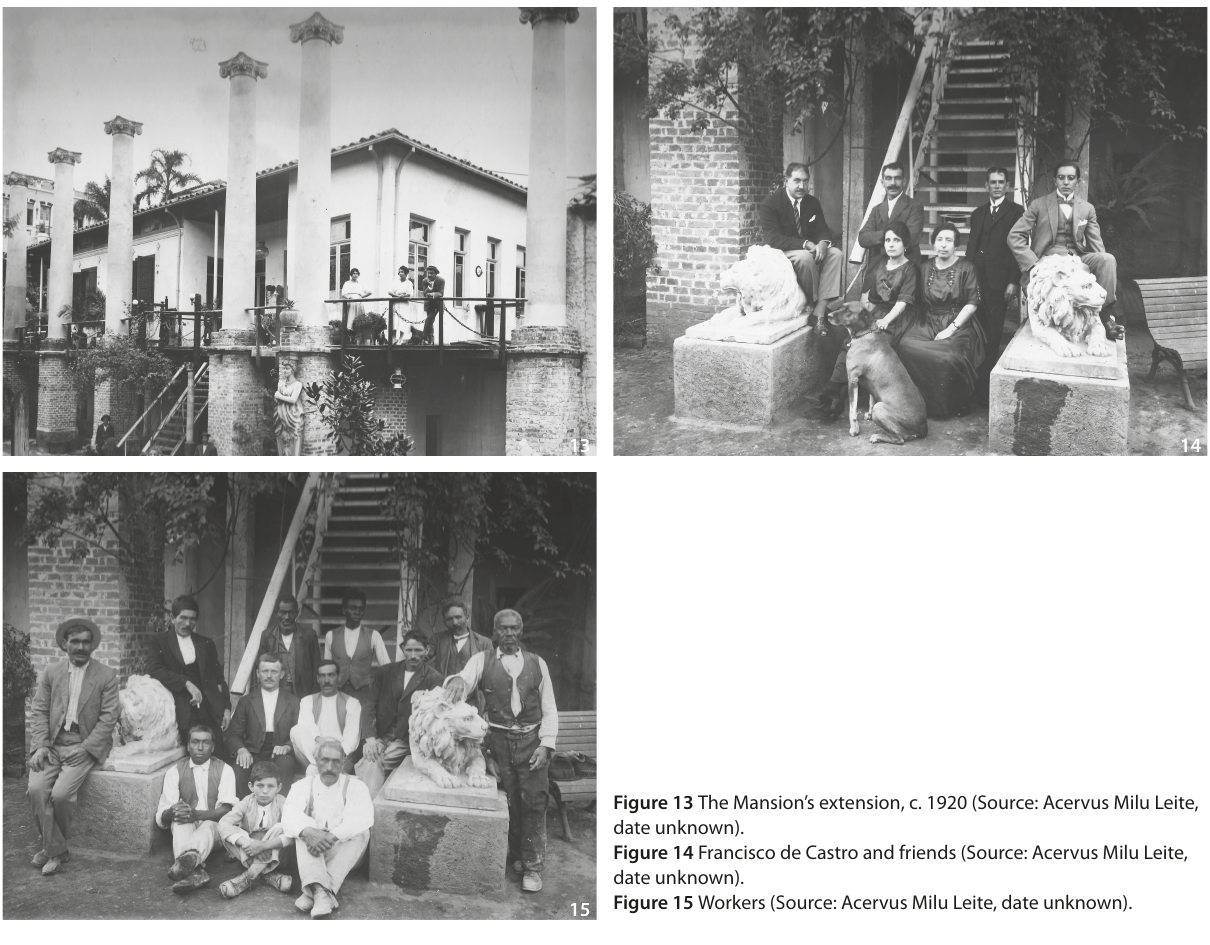
Figure 13 The Mansion’s extension, c. 1920 (Source: Acervus Milu Leite, date unknown). Figure 14 Francisco de Castro and friends (Source: Acervus Milu Leite, date unknown). Figure 15 Workers (Source: Acervus Milu Leite, date